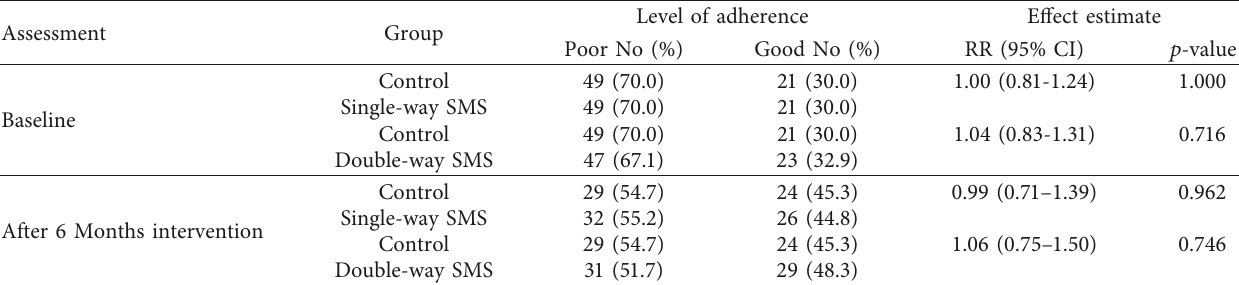
Table 7: Adherence to ART between the single-way and double-way SMS and control of the groups before and after 6 months of intervention.